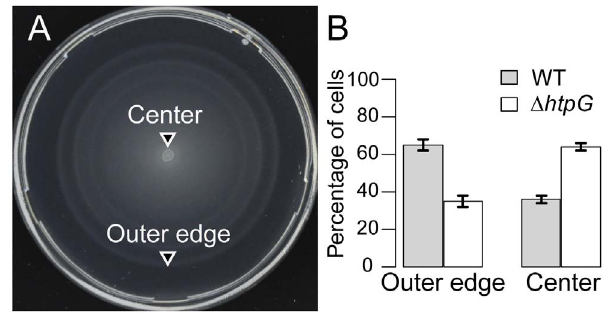
Figure 4. D htpGE.coli cells spread less efficiently on soft-agar plates. Upon equal mixing, WT and D htpG cells were competed for 8 hours at 34 u on the same soft-agar plates, where bacteria spread in a motility- and chemotaxis-dependent fashion. Samples from the outer edge of the plate are thus enriched in cells with optimal chemotaxis and motility, whereas cells from the center are less chemotactic and/or motile. ( A ) A representative image of assay plate. ( B ) Quantitation of different genotypes as determined by percentage of the YFP-labeled WT vs. CFP-labeled D htpG cells at the indicated locations. YFP and CFP expression was induced by 1 m M IPTG. An essentially identical result was obtained for the CFP-labeled WT vs. YFP-labeled D htpG cells (data not shown), confirming that it is label-independent. Error bars indicate standard errors from four replicates. Results were similar at 42 u C (Table